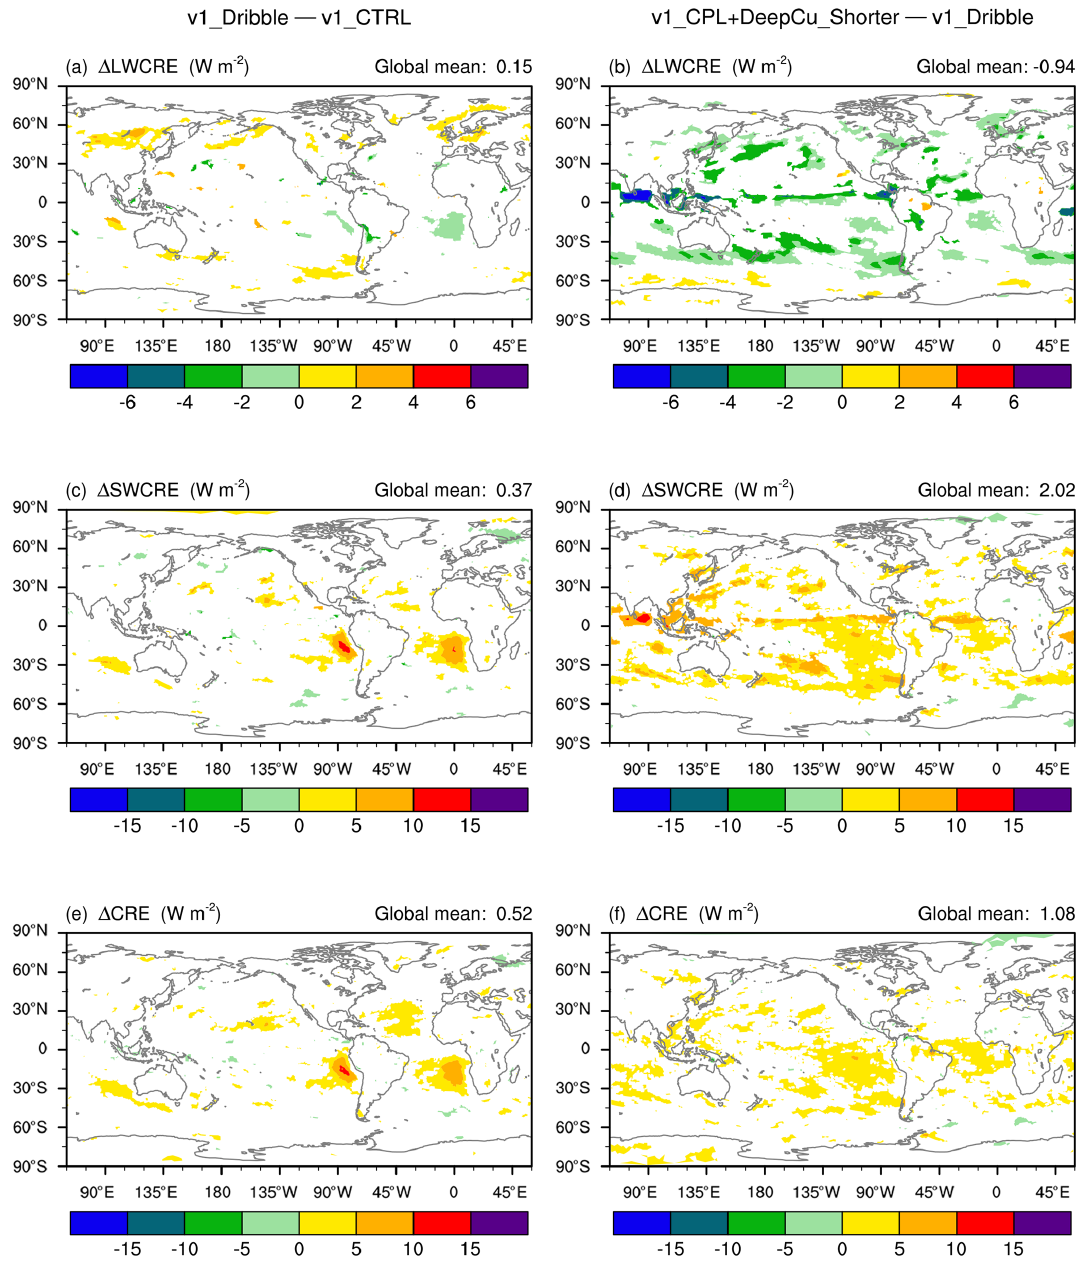
Figure 16. (a, c, e) Differences between v1_Dribble (see the schematic in Fig. 15) and v1_CTRL (see the schematic in Fig. 2), reveal- ing the impact of coupling between the subcycled cloud macrophysics–microphysics and the rest of EAM. (b, d, f) Differences between v1_CPL + DeepCu_Shorter (see the schematic in Fig. 13) and v1_Dribble (see the schematic in Fig. 15), revealing the impact of step sizes used by various other parameterizations (deep convection, gravity wave drag, miscellaneous aerosol processes) and the coupling among them. White indicates statistically insignificant differences. The simulation setups are summarized in Tables 1 and